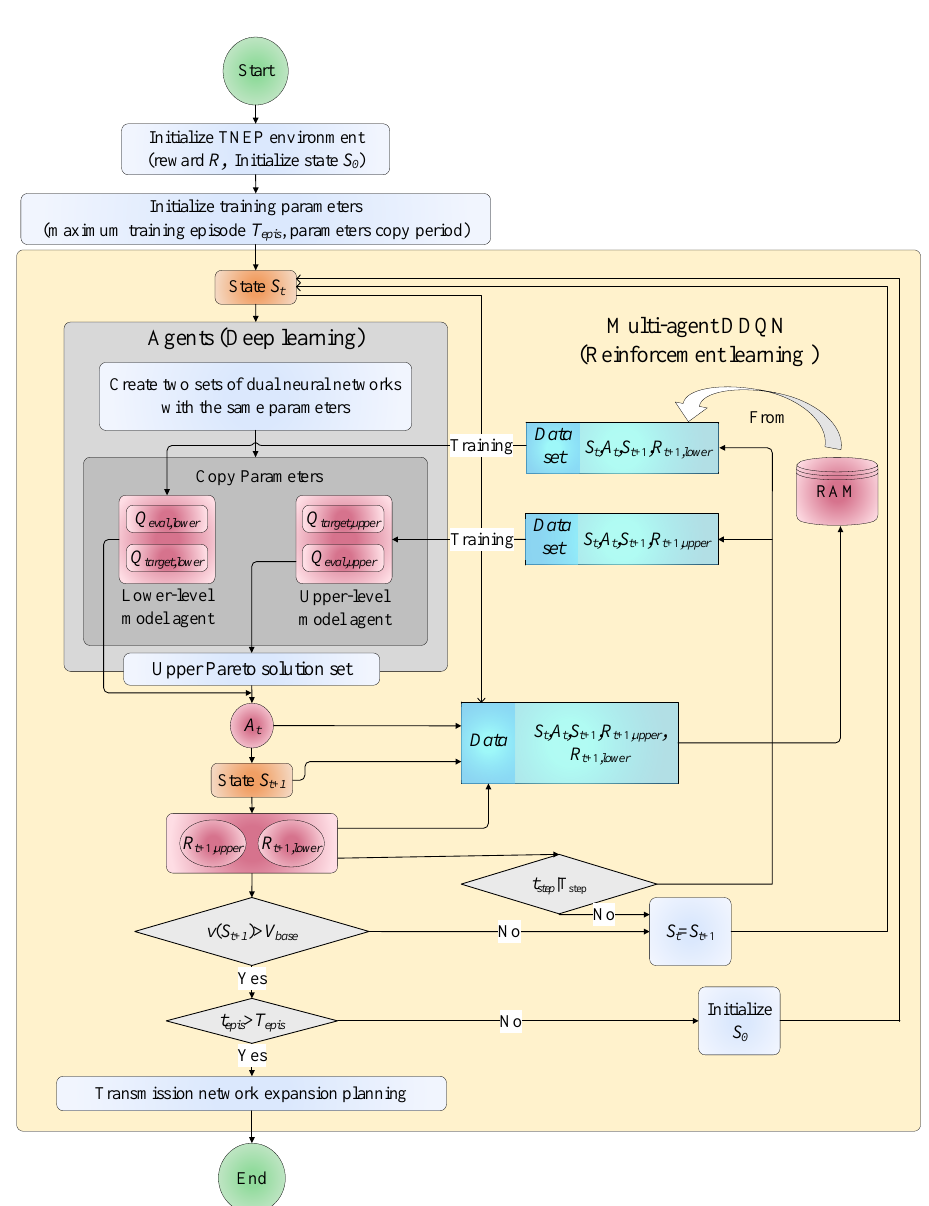
Figure 4. Multi-agent DDQN flow chart of TNEP task.